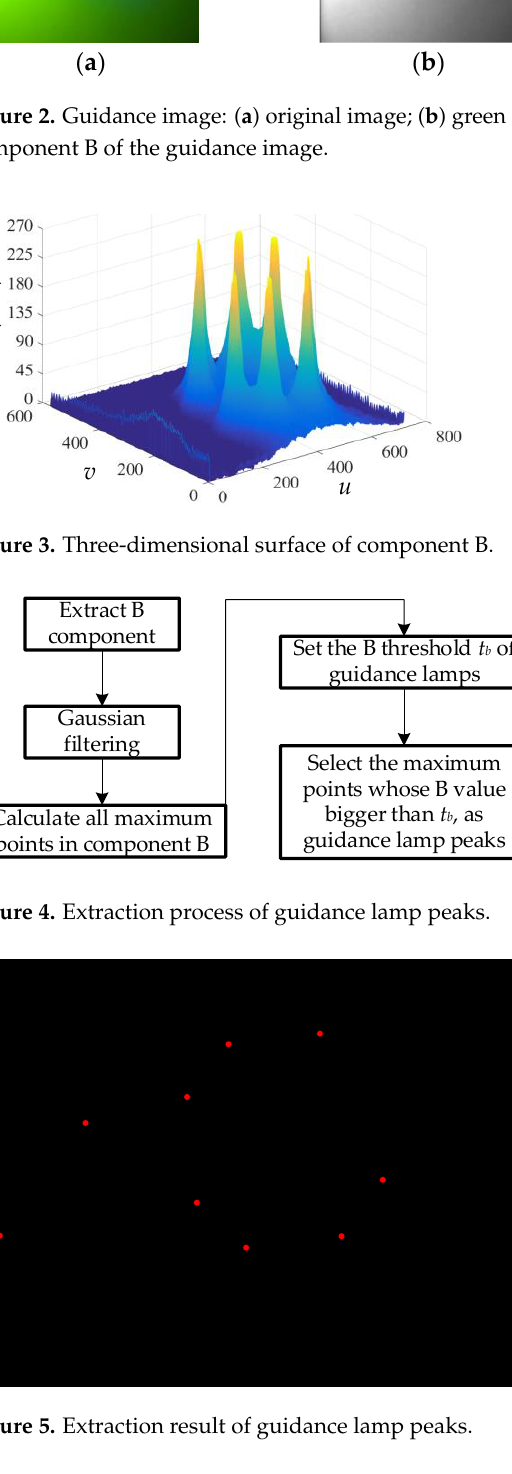
Figure 2. Guidance image: ( a ) original image; ( b ) green component G of the guidance image; ( c ) blue component B of the guidance image.